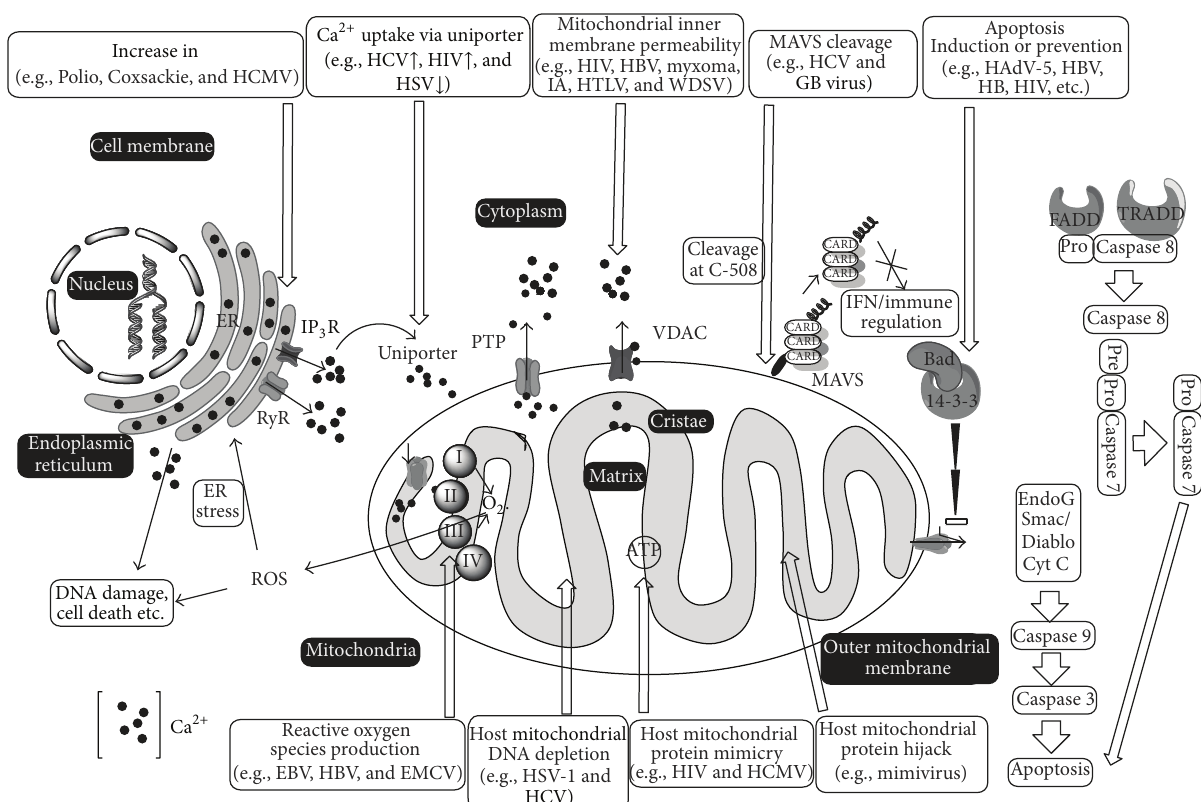
Figure 1: Schematic diagram of cell showing mitochondria, nucleus endoplasmic reticulum (ER) and cell membrane. iCa 2+ : intracellular calcium, FADD: Fas-associated protein with death domain, TRADD: tumor necrosis factor receptor type 1-associated death domain protein, PTP: permeability transition pore, VDAC: voltage-dependent anion channel, IP 3 R: inositol 1,4,5-trisphosphate receptor, RyR: ryanodine receptor, MAVS: mitochondrial antiviral signaling, I, II, III, and IV are complex I to IV of electron transport chain. O 2− : Superoxide radical, Bad, Bcl-2-associated death promoter, ROS: reactive oxygen species, IFN: interferon, HCMV: human cytomegalovirus, HIV: human immunodeficiency virus, HSV: herpes simplex virus, HBV: hepatitis B virus, HTLV: human T-lymphotropic virus, IA: influenza A virus, WDSV: Walleye dermal sarcoma virus, HCV: hepatitis C virus, HAdV: human adenovirus-5, EBV: Epstein-Barr virus, and EMCV: encephalomyocarditis